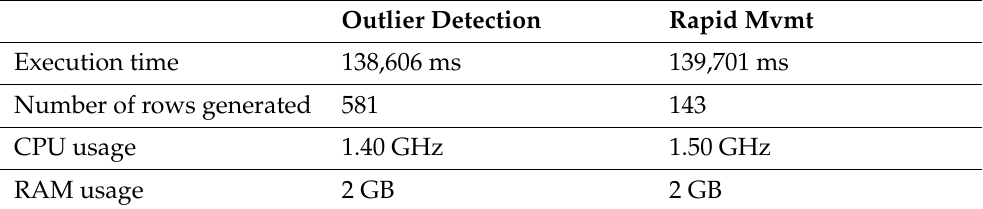
Table 2. Summary of experimental